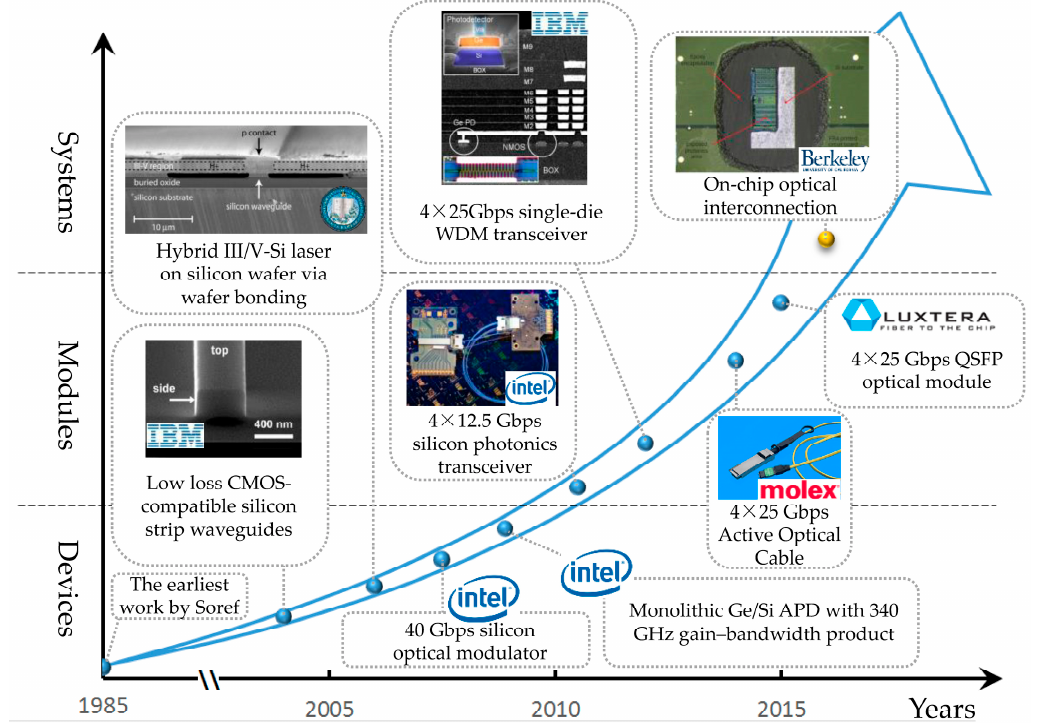
Figure 1. The development trend of silicon-based optoelectronics and some significant works in the past few decades. Figures reproduced from [11–16].